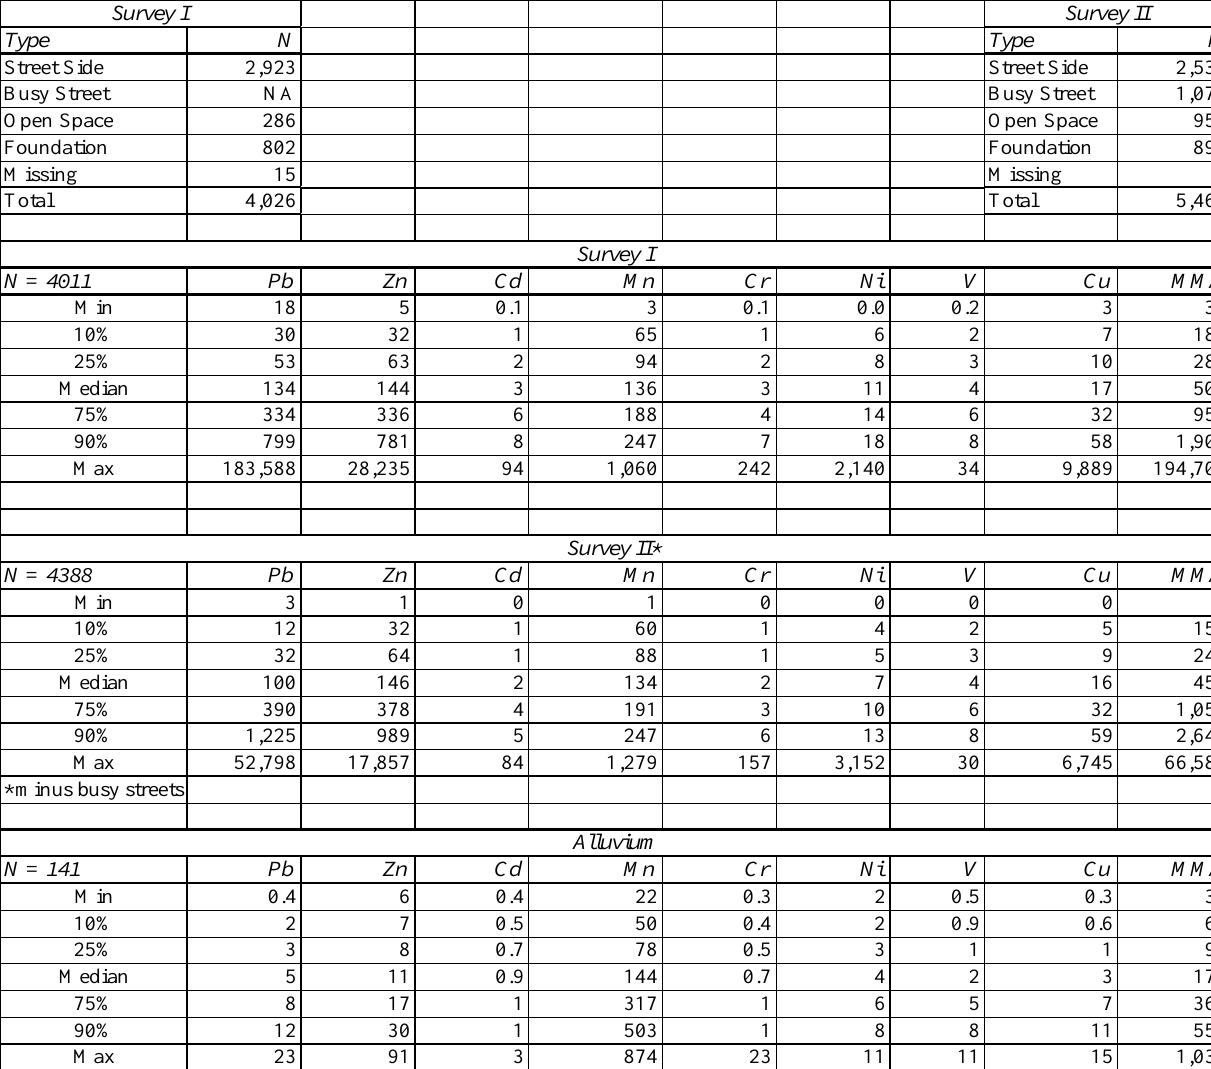
Table 2: Results of transformed metals of Survey I, soil metal data for Survey II, and Alluvial Parent Material of the Mississippi River Delta. All metal results are given in